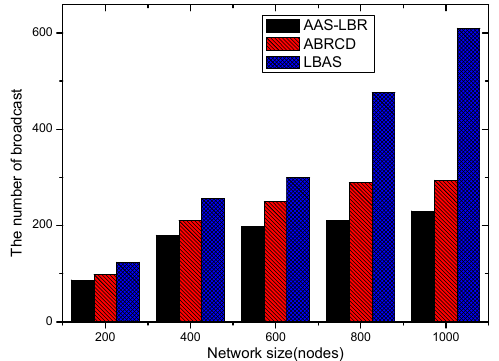
Figure 37. The impact of network size with fixed | T | = 30 on the number of broadcasts.